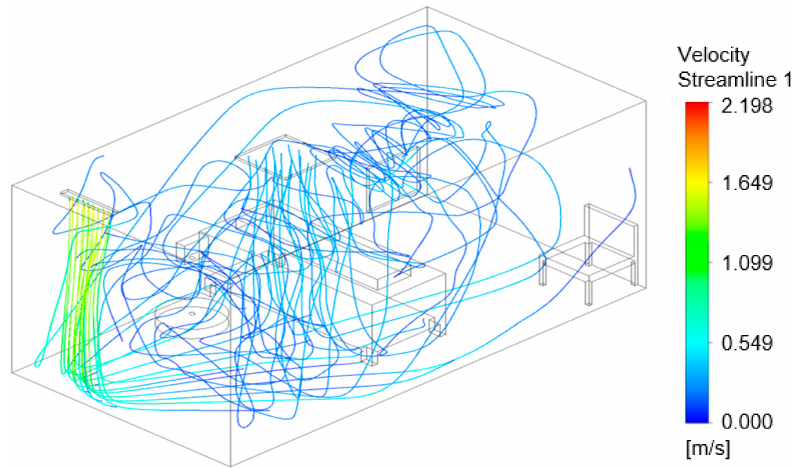
Figure 18. Computational flow model showing airflow velocity streamlines for configuration